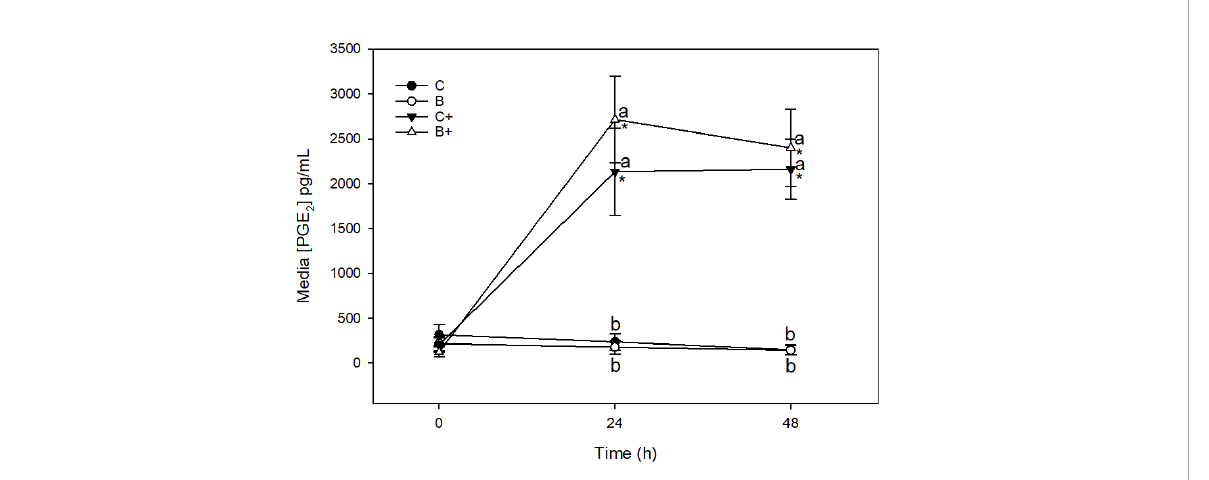
FIGURE 6 Media [PGE2] (µg/mL) from expalnts cultured in basal media (C) or media conditioned with 1% DD20:Ethanol (0.3%) (B) in the presence (+) or absence of lipopolysaccharide (10 µg/mL). *denotes signi fi cant change from baseline within treatments. Letters denote signi fi cant difference between treatments at individual time